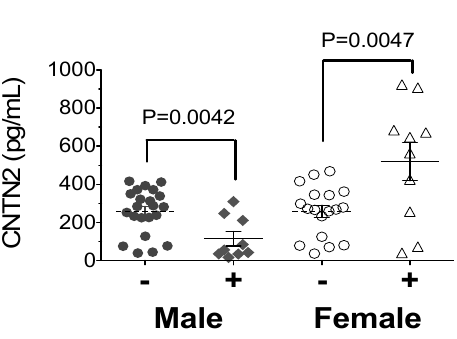
Figure 2. Male infants of diabetic mothers have significantly lower CNTN2 levels, while female infants of diabetic mothers have significantly higher CNTN2 levels.